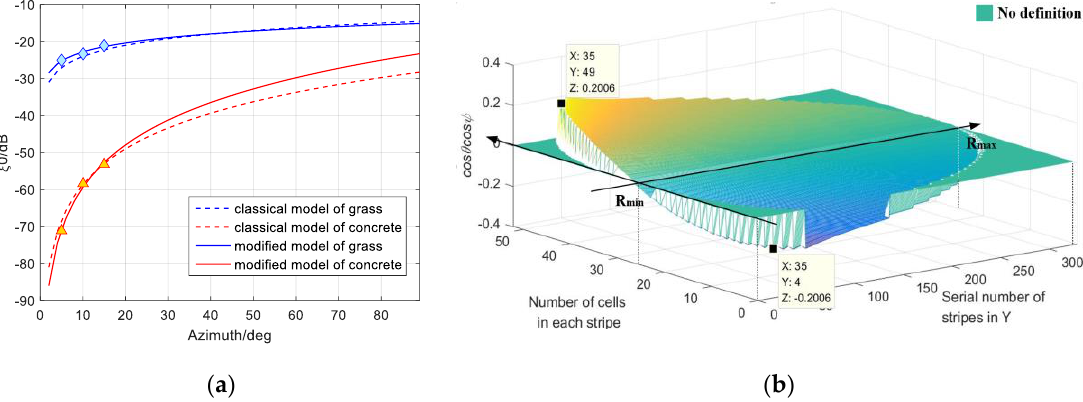
Figure 8. ( a ) Comparison between traditional Kulemin model and the data fitting results; ( b ) cos θ of each cell ranges from − 0.2006 to 0.2006, which constrains